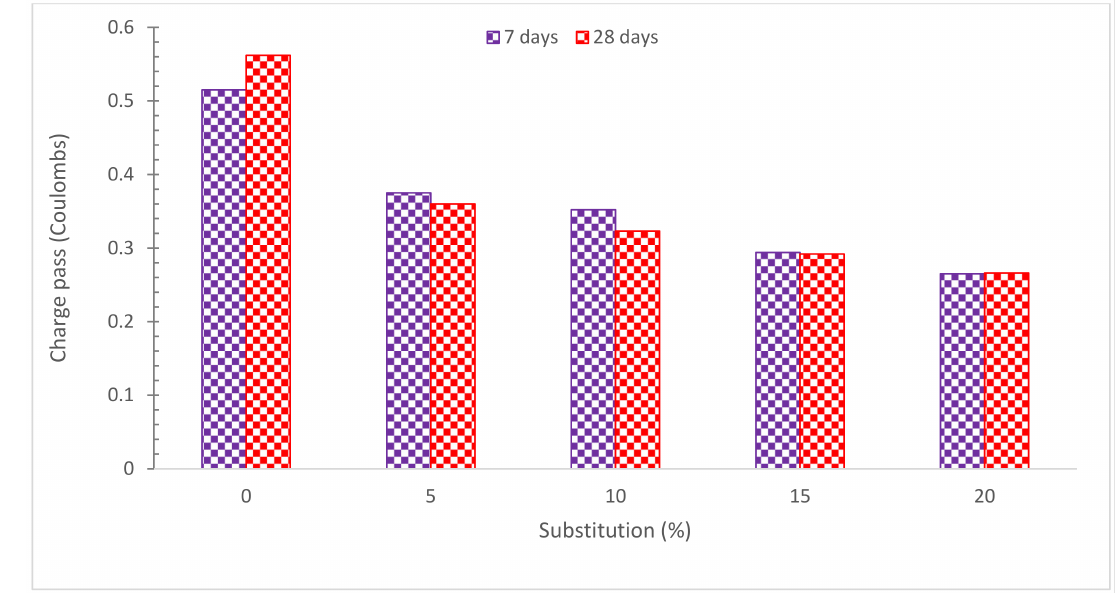
Figure 16. Chloride Permeability [67].